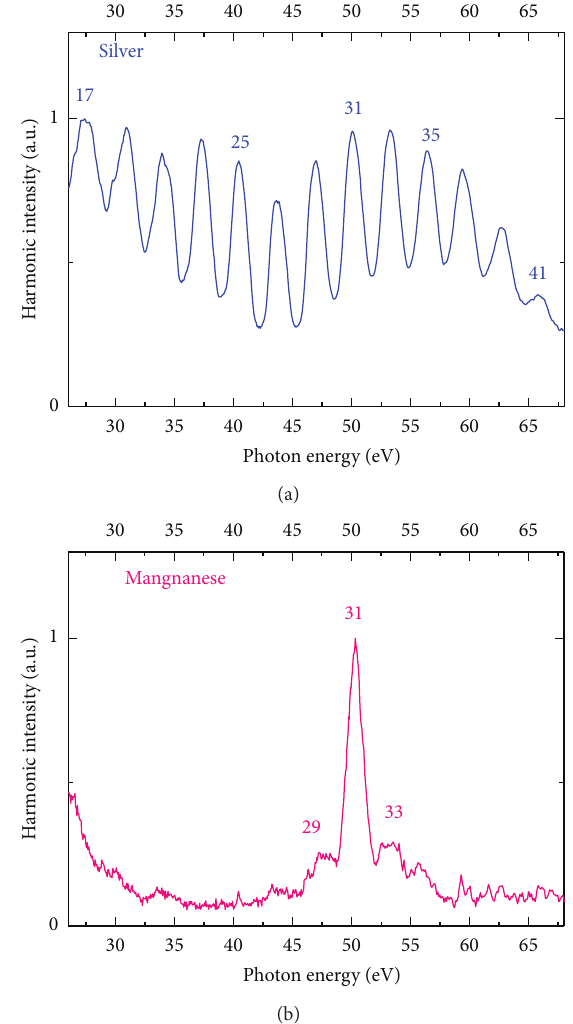
Figure 11: Harmonic spectra from the silver plasma (a) and manganese plasma (b)